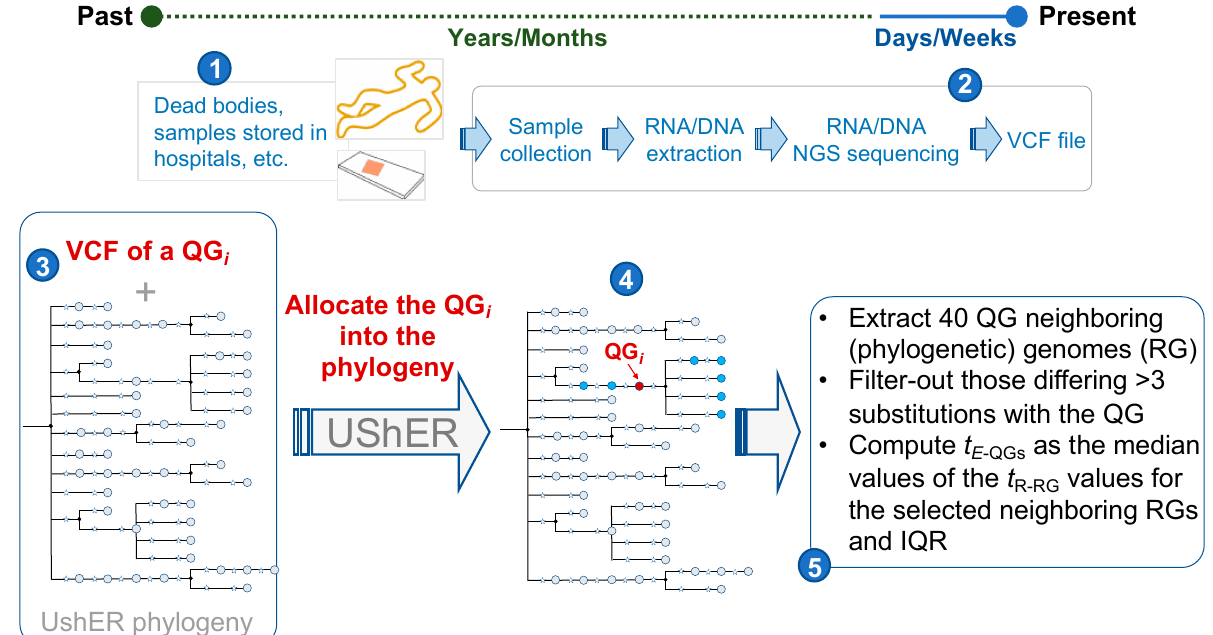
Figure 6. Diagram showing the VMCD procedure employed in the present project. The VMCD method allows to date queried viral genomes from about one month ago backwards ( 1 ). A biological sample is collected, and its RNA is extracted and sequenced ( 2 ); its sequence (QG) can be examined using available software (e.g., [19]), and, using an standard format (VCF) it is introduced in the pipeline ( 3 ) and allocated to its most likely node within the large SARS-CoV-2 phylogeny ( 4 ). Then, the neighboring RGs are retrieved, and their sampling times (t R-RG ) processed, as indicated in the methodology section, to finally obtain the required t E-QG value ( 5 ). The original database has 5,322,161 genomes that were used to build a huge UShER phylogenetic tree. A total of 20,000 genomes are extracted from the GenBank database and used as queried genomes (QG); the final reference database therefore contains 5,322,161 genomes. VCF: Variant Calling Format (typically used to process DNA/RNA sequences); t E-QG : estimated date of the sequence QG; t R-RG : estimated date of the sequence RG.